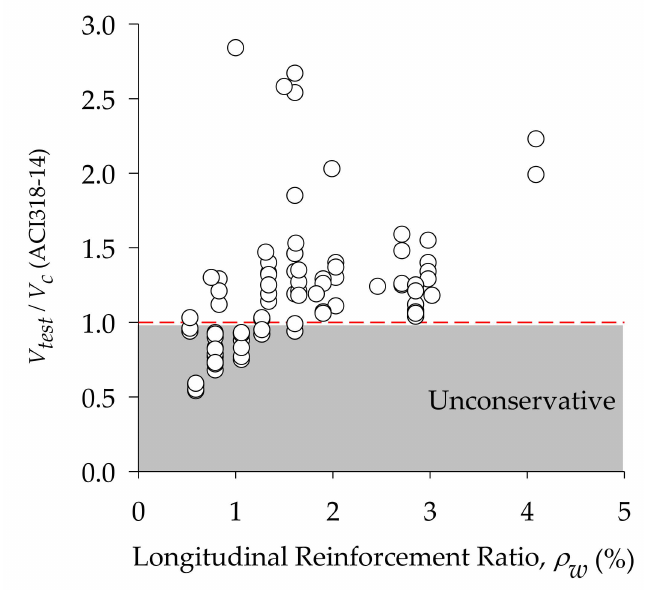
Figure 11. V test /V c using ACI 318-14 simplified shear equation for different ρ w .